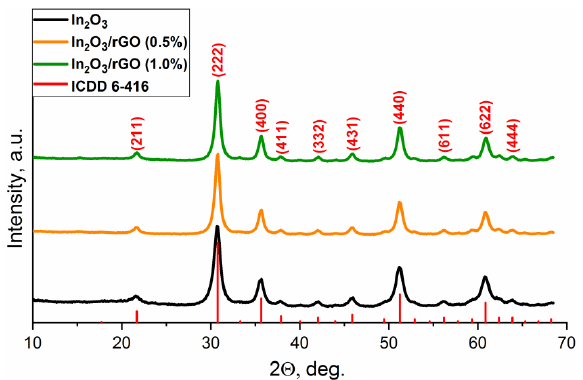
Figure 1. XRD patterns of the In 2 O 3 and In 2 O 3 /rGO composites.